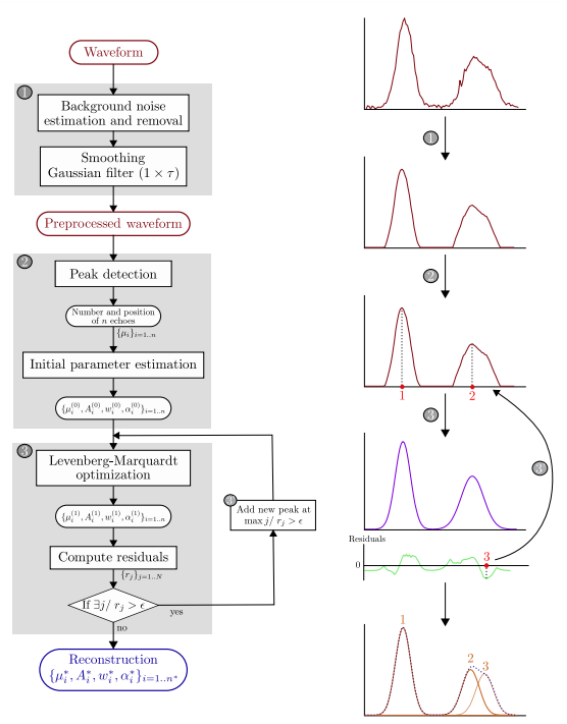
Figure 8. Principle of the Gaussian decomposition algorithm (scheme by